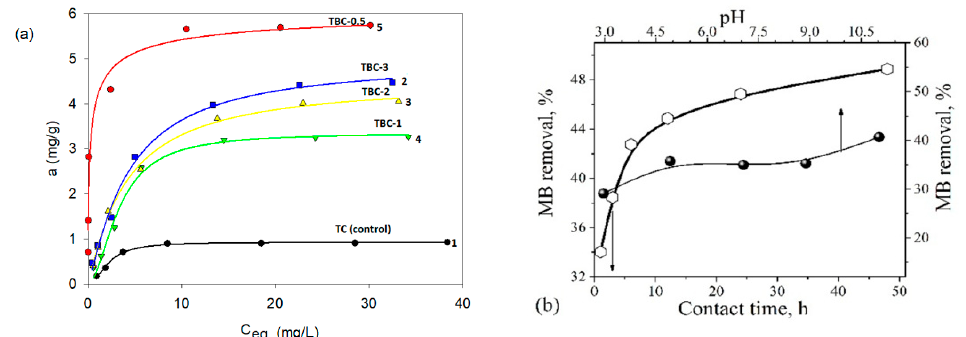
Figure 6. The scheme of synthesis of biochars from tannin and bentonite with possible mechanisms for methylene blue and phenol adsorption.